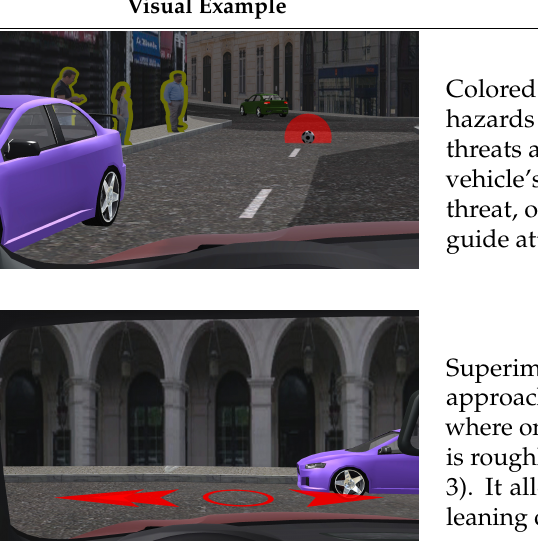
(a) Threat and warning markers Colored object outlines warning drivers of potential hazards on or beside the road. Warnings for possible threats are given as yellow markers. Direct threats in the vehicle’s path are marked in red. In case of an imminent guide attention to the position of the hazard.